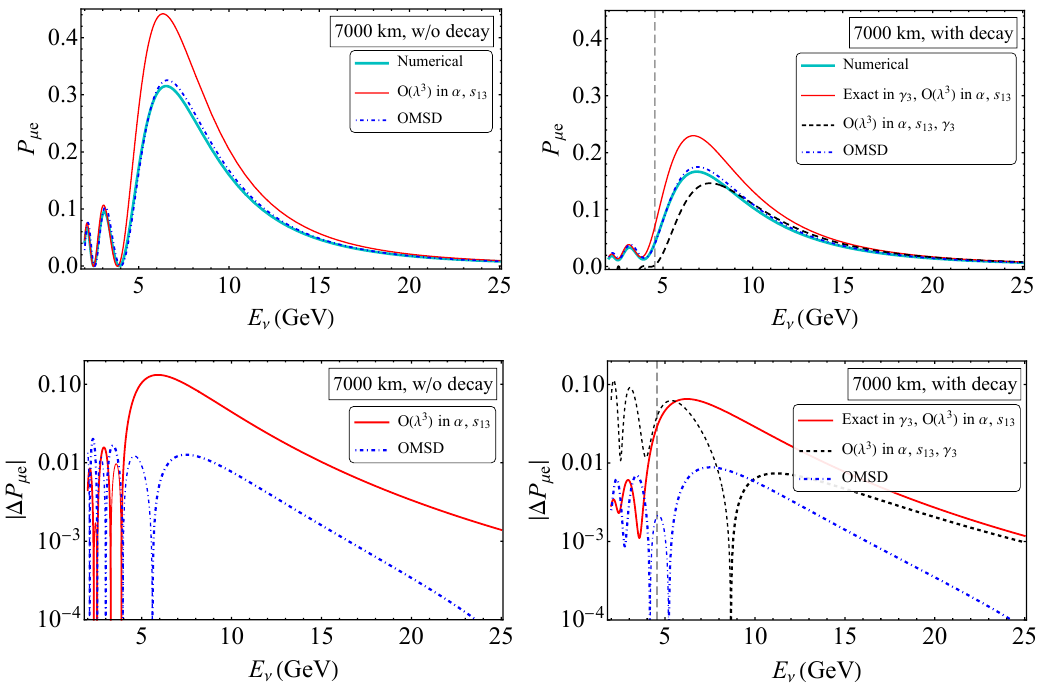
Figure 4 . The top panels show probabilities P µe in the scenarios without (left) and with (right) decay, for L = 7000 km and γ = 0 . 1 . The bottom panels show the absolute error | ∆ P 3 analytic expressions shown. The thick (thin) curves indicate positive (negative) signs of ∆ P dashed gray vertical line follows the same convention as that mentioned in figure